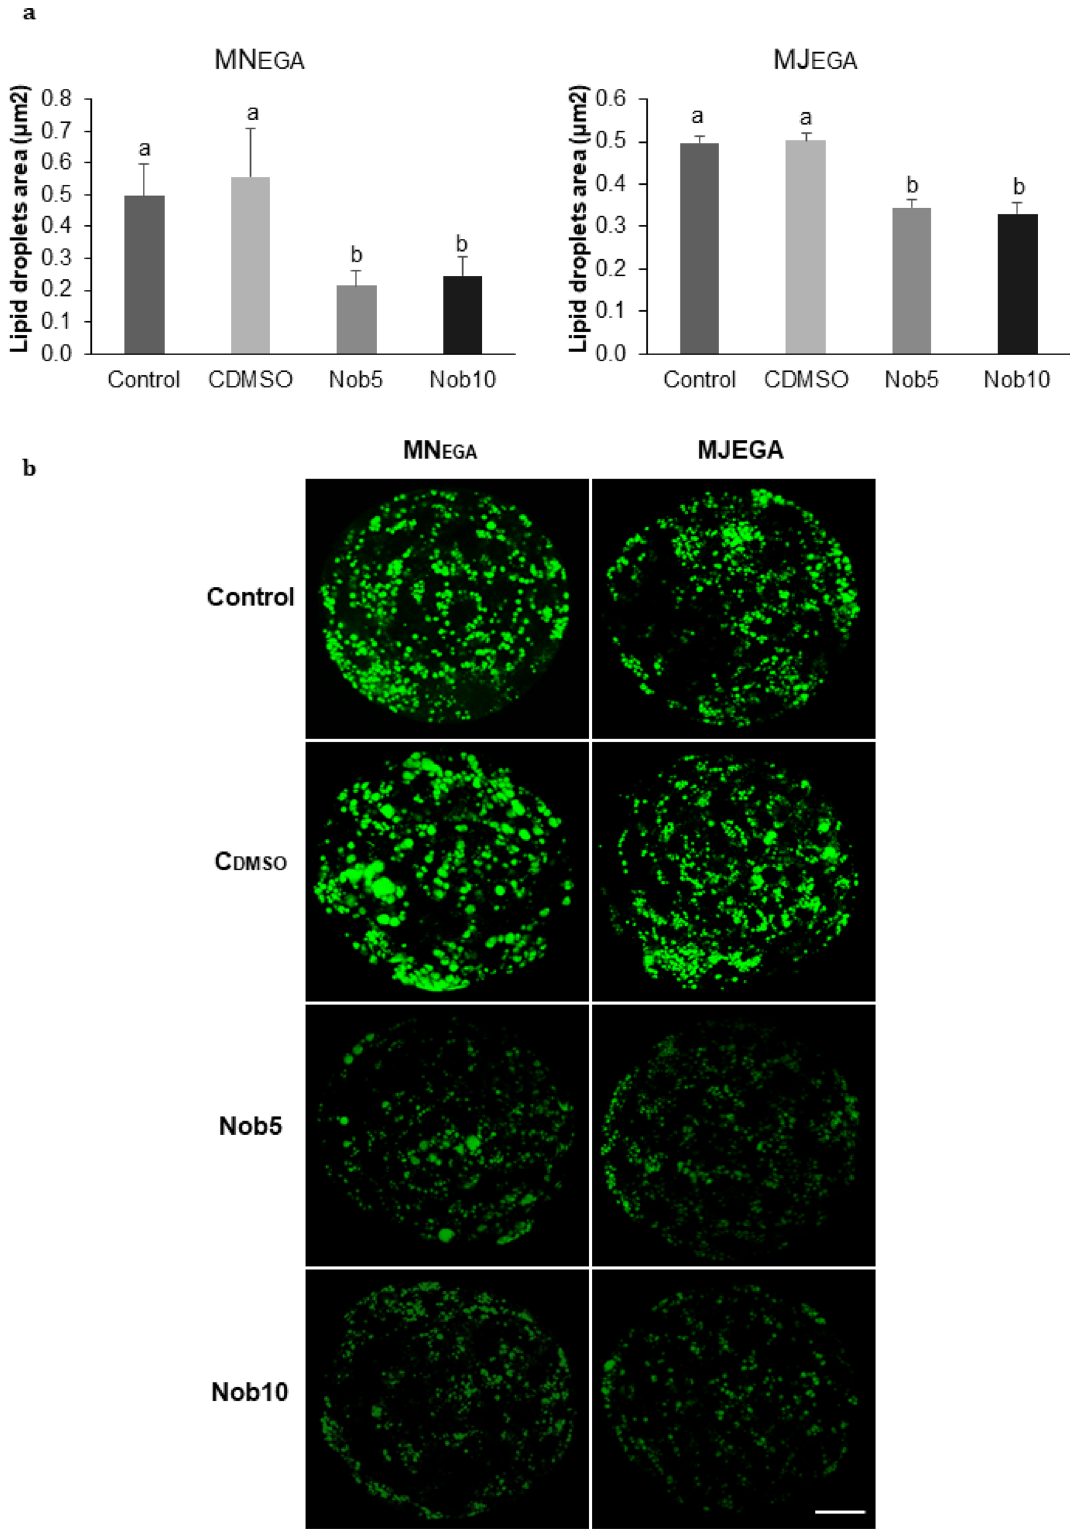
Figure 3. Nobiletin effect in blastocysts lipid content. ( a ) Quantification of the total area of lipid droplets (µm 2 ) in Day 7 blastocysts cultured in SOF + 5% FCS (Control), supplemented or not with 5 (Nob5) or 10 µM (Nob10) nobiletin or with 0.03% dimethyl sulfoxide (C DMSO ) during 21–54 hpi (MN EGA : presumptive zygote to 8-cell stage) or during 54–96 hpi (MJ EGA : 8- to 16-cell stage). Data are the mean ± s.e.m. Significant differences ( P < 0.001) are indicated with different letters. ( b ) Representative fluorescence images of lipid droplets in Day 7 blastocysts from all experimental groups (Control, Nob5 Nob10, C DMSO ) in both phases (MN EGA or MJ EGA ). Images were captured on 63× objective. Scale bar 50